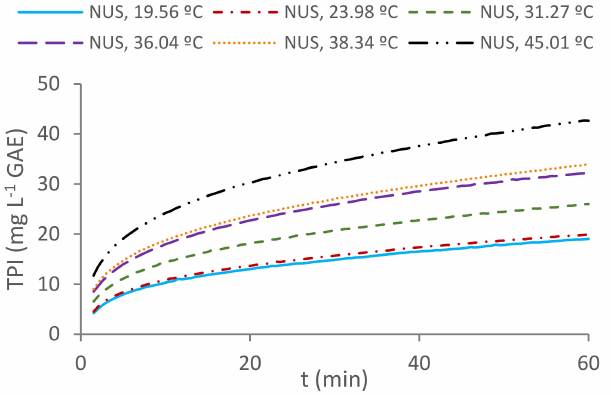
Figure 2. TPI vs. time plots of the non-sonicated extractions carried out at different temperatures (NUS). In relation with the temperature of the extraction media, higher extraction curves are obtained as the solvent’s temperature is increased. In fact, the TPI obtained after 60 min at 45.01 ◦ C was 42.659 ± 0.469 mg · L − 1 GAE, which doubles the TPI measured in the same time lapse of the extraction at 19.56 ◦ C, with values reaching just 19.054 ± 0.229 mg · L − 1